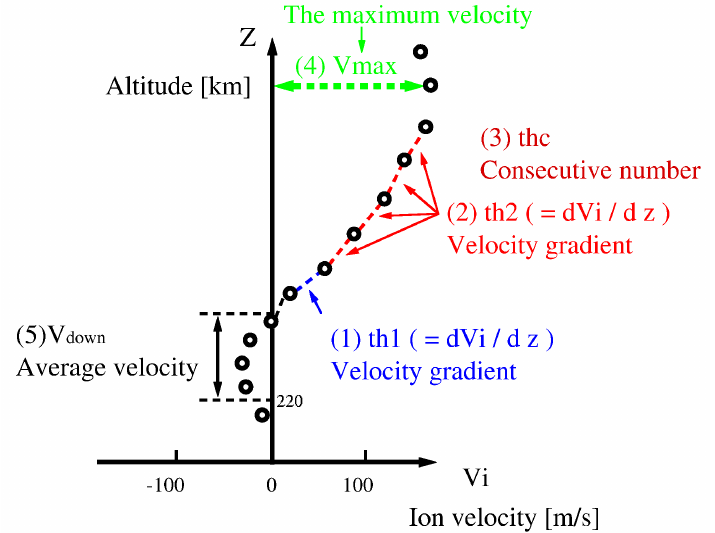
Fig. 7. The criteria for searching velocity profiles automatically for simultaneous up- and downflow events are illustrated. An upflow event is detected if 1) the velocity gradient at the lowest positive velocities exceeds 0.3ms − 1 km − 1 , 2) there is an increasing velocity for at least 3 more data points above, with a gradient of at least 0.2ms − 1 km − 1 , and the highest positive velocity is at least 200ms − 1 . A simultaneous downflow is detected, if 1) there is an upflow event and 2) the average velocity over 4 data points below the upflow is less than -20ms − 1